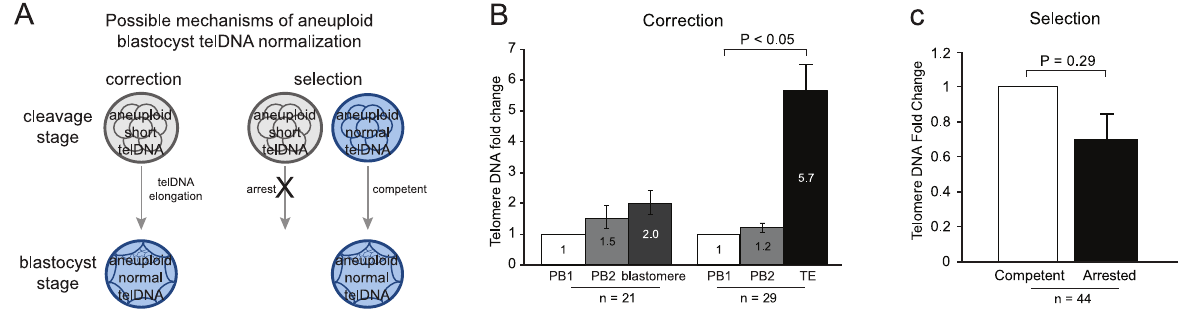
Figure 4. Telomere DNA in aneuploid blastocysts. (A) Diagram illustrating two potential mechanisms by which aneuploid blastocysts could obtain normalized quantities of telomere DNA. (B) Results of testing the potential for ‘‘correction’’ to explain normalized quantities of telomere DNA in aneuploid blastocysts. A significant increase ( P , 0.05) was found in telomere DNA quantity in trophectoderm from blastocysts relative to the 1 st polar body from the same oocyte. A significant increase was not found in blastomeres from cleavage stage embryos. This suggests that telomere DNA is reset between the cleavage and blastocyst stage of embryogenesis in humans. (C) Results of testing the potential for ‘‘selection’’ to explain normalized quantities of telomere DNA in aneuploid blastocysts. Significance was not reached when comparing sibling arrested and developmentally competent embryos ( P =0.29). This suggests that embryos with short telomeres aren’t more prone to developmental arrest between the cleavage and blastocyst stage of embryogenesis in humans.